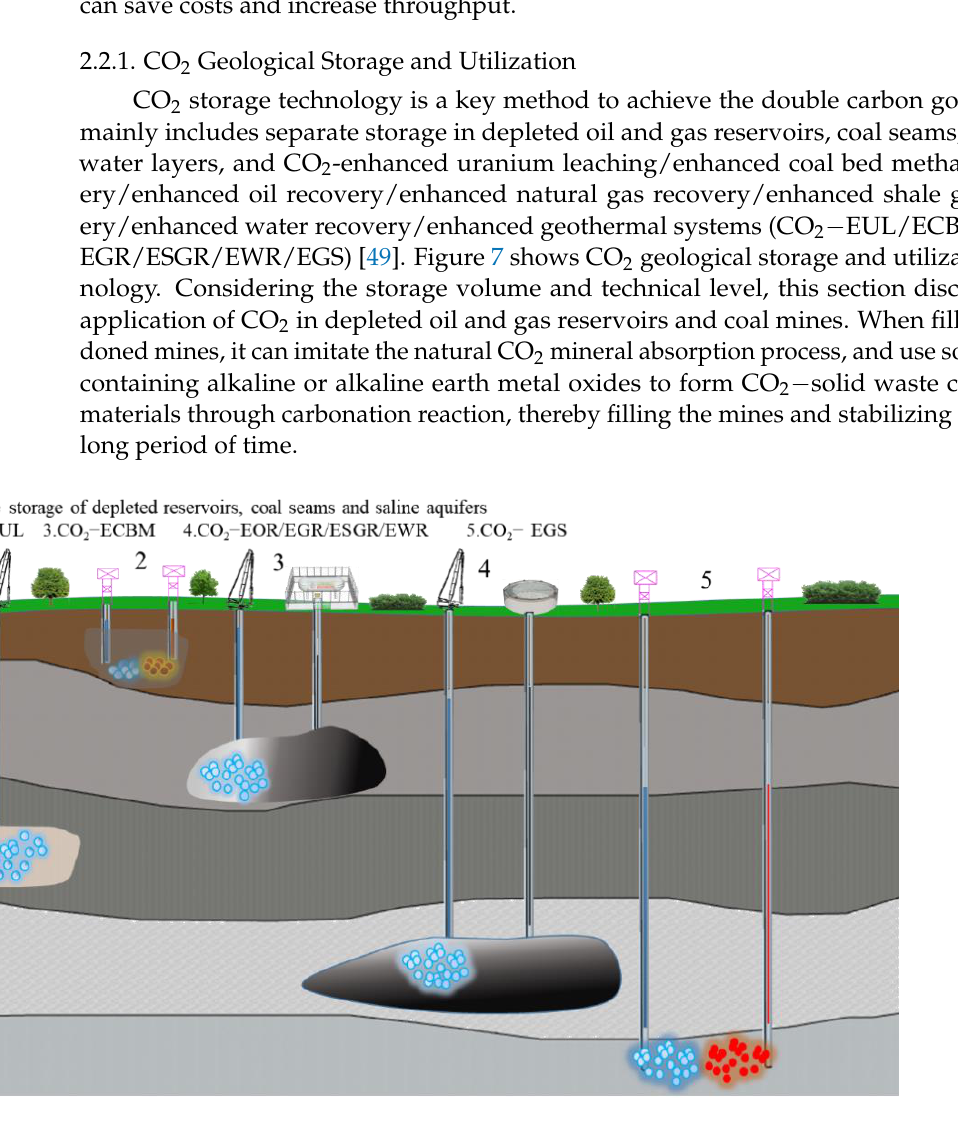
Figure 7. CO 2 geological storage and utilization technology.